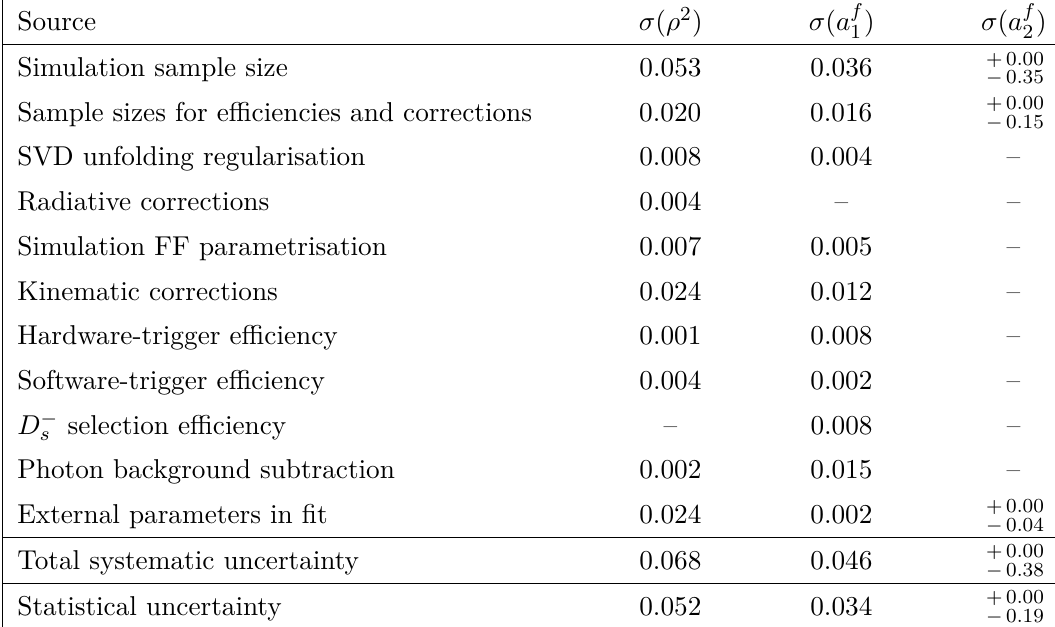
Table 4 . Summary of the systematic and statistical uncertainties on the parameters ρ 2 , a f from the unfolded CLN and BGL fits. The total systematic uncertainty is obtained by adding the individual components in